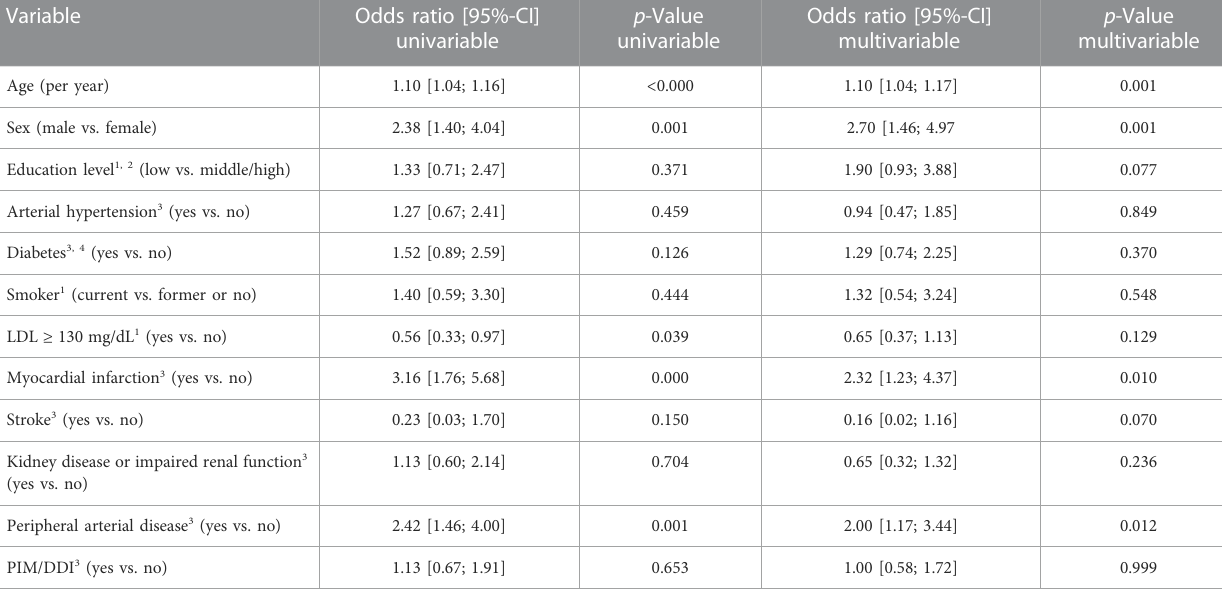
TABLE 2 Univariable models and multivariable model for the endpoint death (2,120